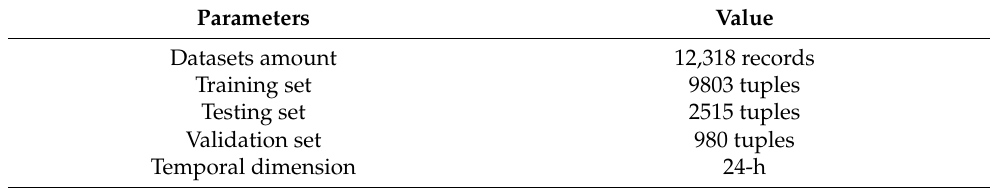
Table 3. Partition of the experimental